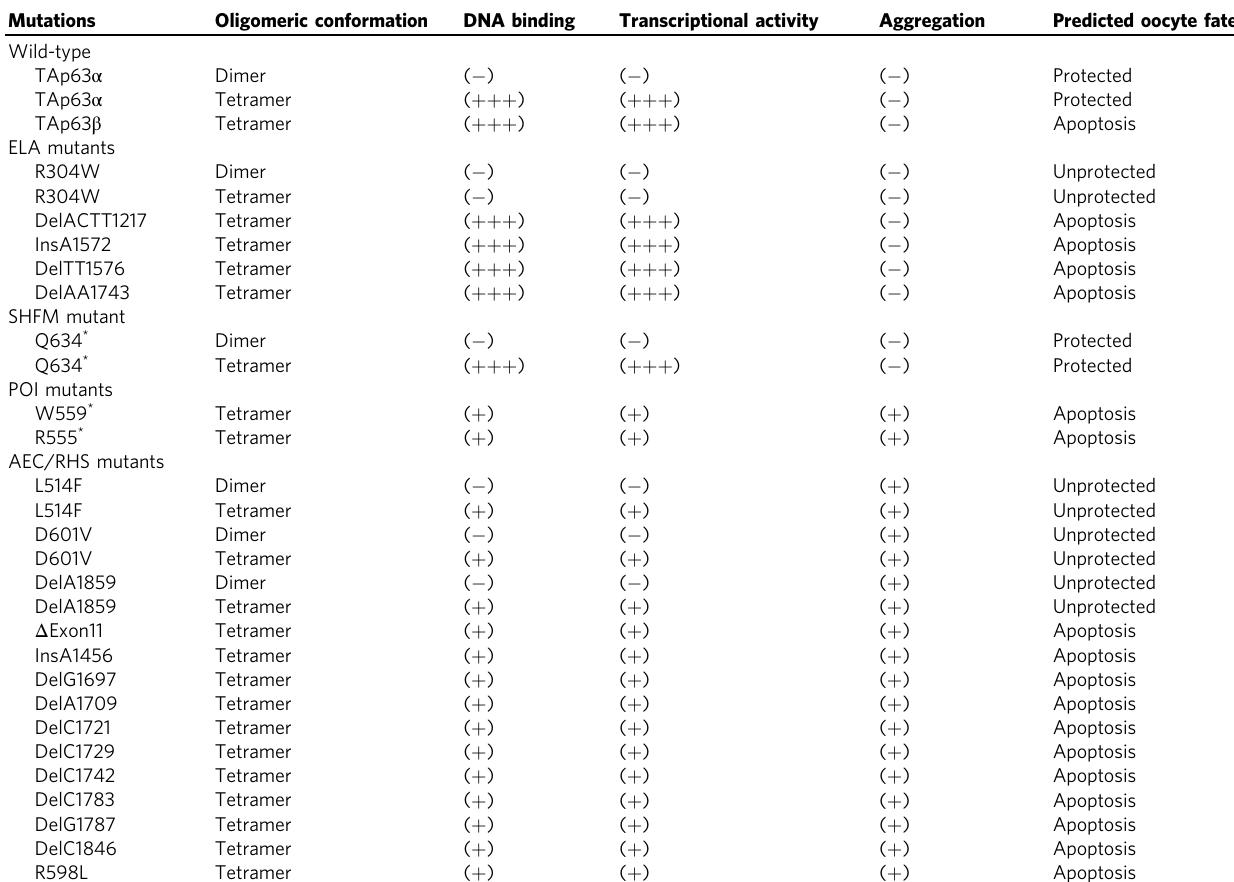
Table 1 Summary table of predicted oocyte